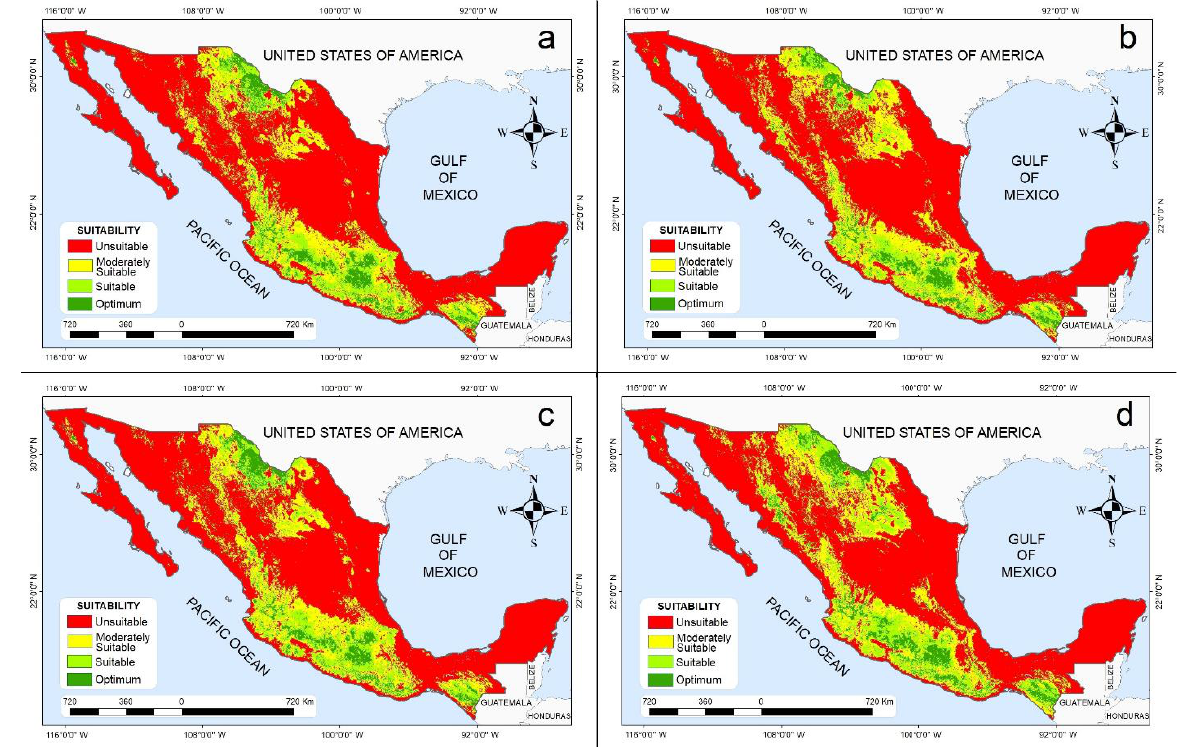
Figure 4. ( a ) MPI-ESM-LR 2050 RCP 2.6, ( b ) MPI-ESM-LR 2050 RCP 8.5, ( c ) MPI-ESM-LR 2070 RCP 2.6 y, and ( d ) MPI-ESM-LR 2070 RCP 8.5.